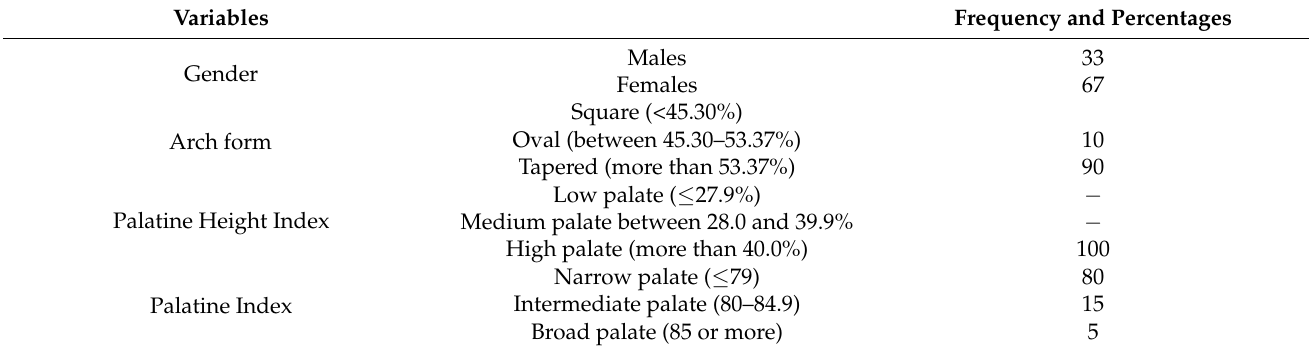
Table 2. Frequency and percentages of different variables of the study sample.